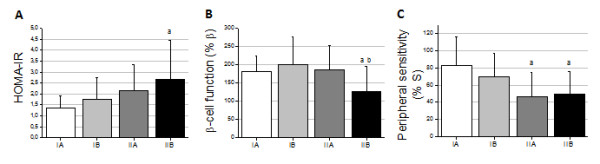
Evaluation of peripheral insulin sensitivity and β-cell function in patients by HOMA2 model. These graphs show: (A) significant increase of HOMA-IR values (A), decreased β-cell-function (B), and decreased peripheral insulin sensitivity (C) in IIB group when compared with IA group. IIA group of patients also exhibited decreased peripheral insulin sensitivity, compared with IA group (C). The values are mean ± SD. asignificantly different vs IA; bvs IB. p < 0.05.